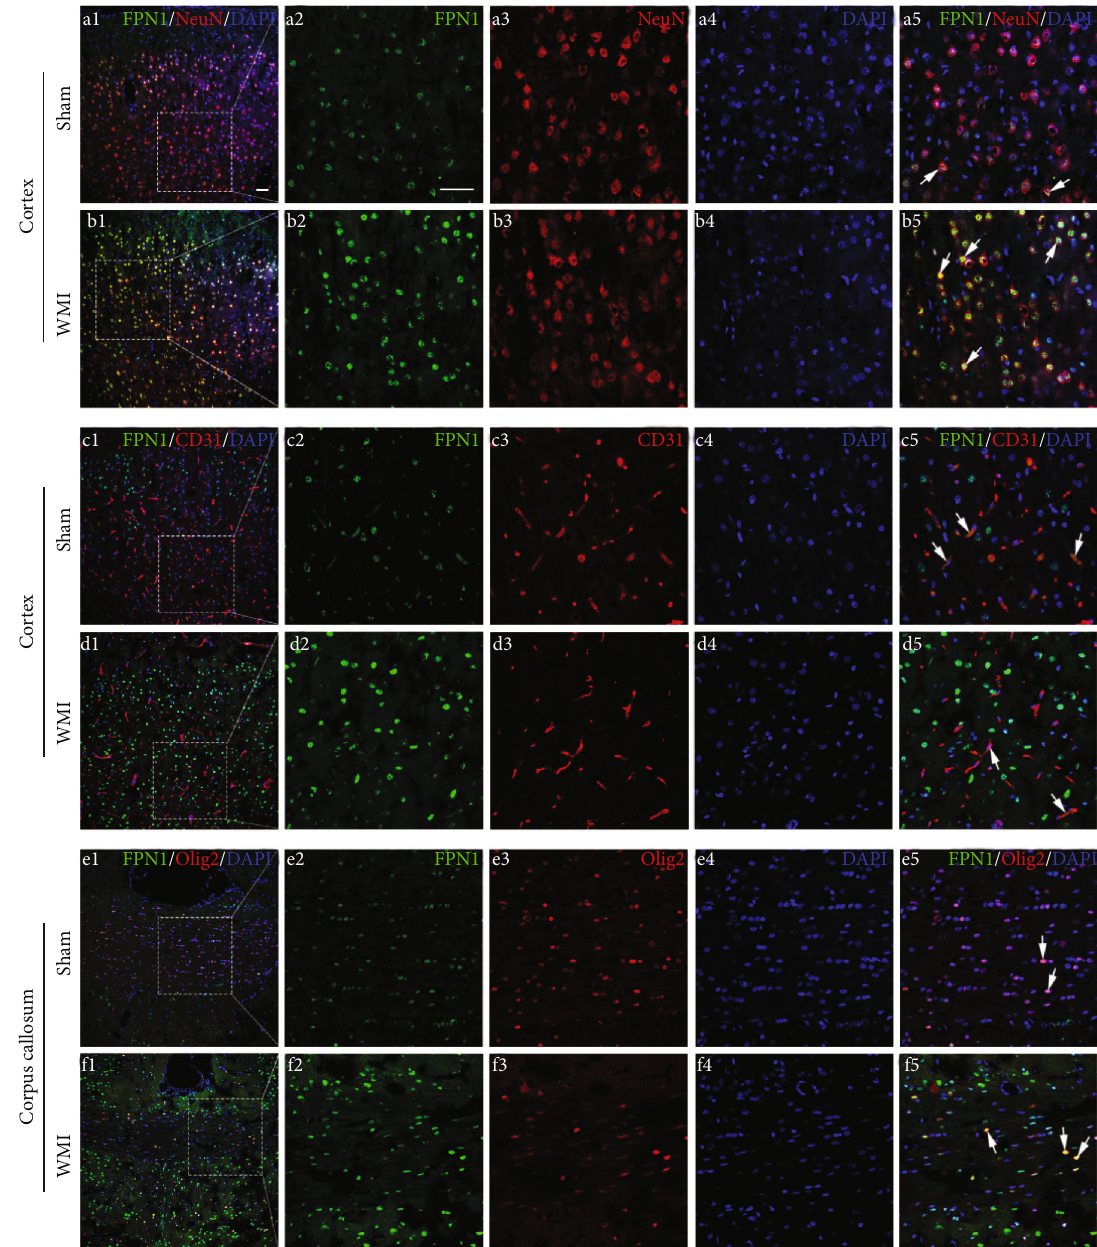
Figure 6: Representative images of immuno fl uorescence staining for FPN1 (green), NeuN (neuronal marker; red)/CD31 (vascular marker; red)/Olig2 (oligodendrocyte marker; red), and DAPI (nuclear marker; blue) in rat brains on POD 28. FPN1-positive cells were colocalized with NeuN- or CD31- or Olig2-positive cells; however, they were largely observed in the WMI group than in the sham group. White arrows indicate FPN1 + NeuN + cells in a5 and b5, FPN1 + CD31 + cells in c5 and d5, and FPN1 + Olig2 + cells in e5 and f5. Scale bar, 50 μ